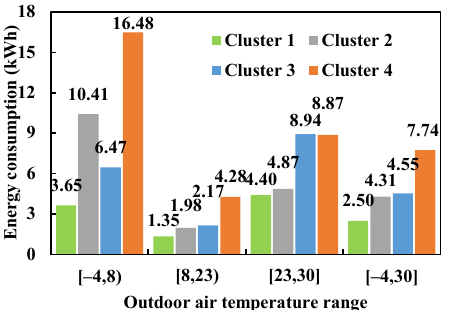
Figure 12. Average energy consumption of each dormitory at different outdoor air temperature intervals.